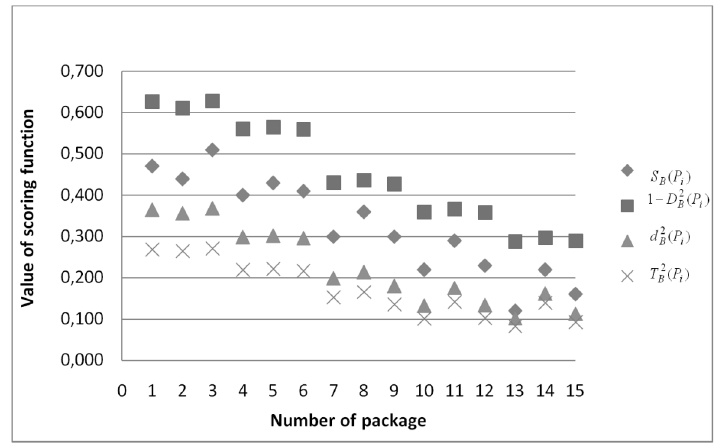
Figure 7. The scoring systems for the Buyer – an overview